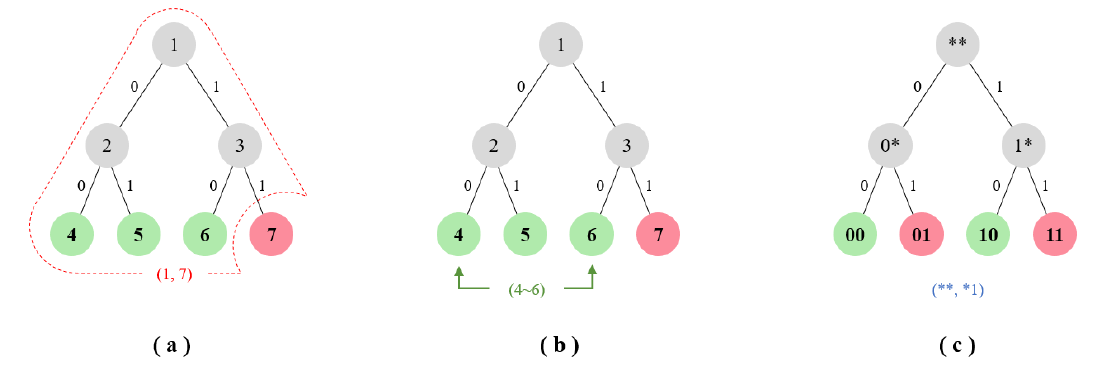
Figure 1. Subset construction examples in ( a ) SD, ( b ) interval, and ( c ) combinatorial subset difference (CSD)